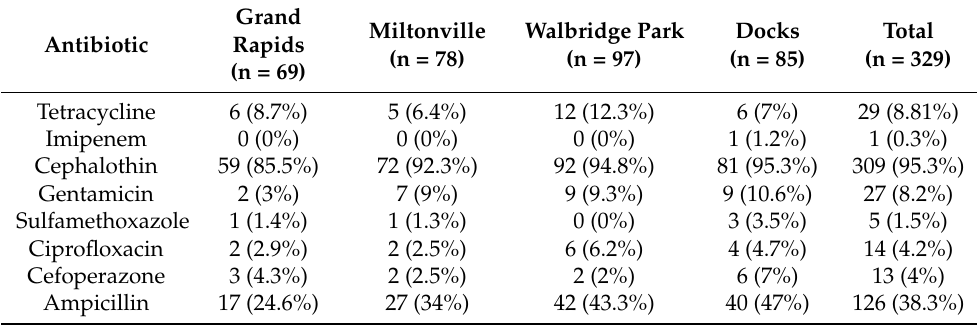
Table 2. Number of E. coli isolates (%) expressing resistance to antibiotics, by sampling site, across all sampling events.